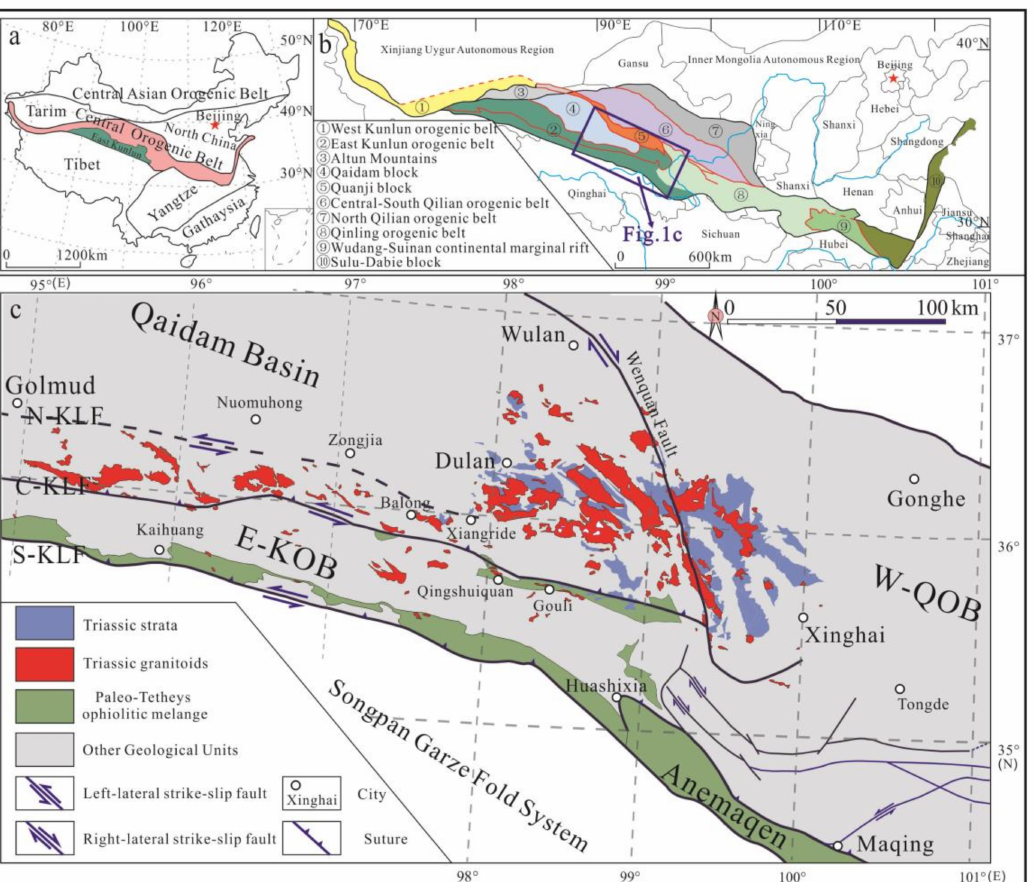
Figure 1. ( a , b ) Tectonic map of China revised after [14]. ( c ) Schematic geological map of the Eastern Kunlun Orogenic Belt, N-KLF: North Kunlun Fault; C-KLF: Center Kunlun Fault; S-KLF: South Kunlun Fault; E-KOB: East Kunlun Orogenic Belt; W-QOB: West Qingling Orogenic Belt (simplified and modified after